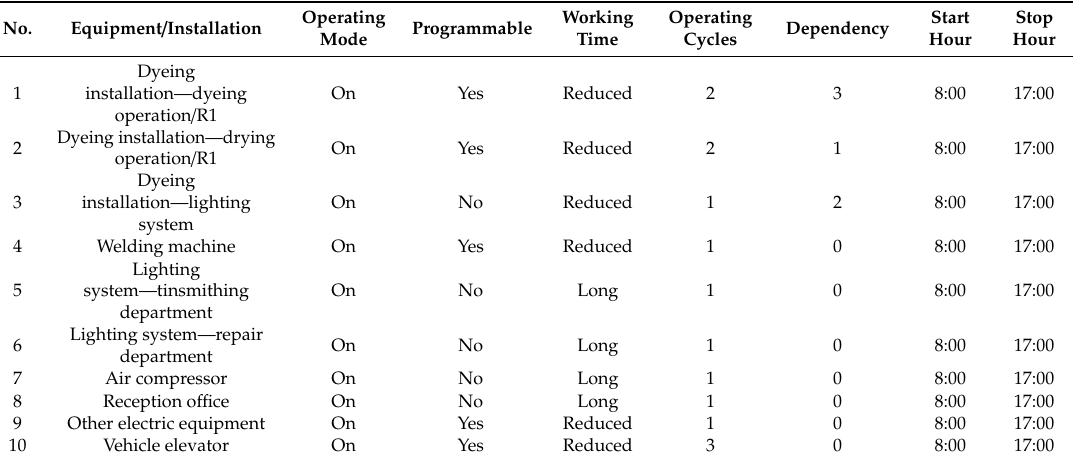
Table 11. The input data matrix (IDM).